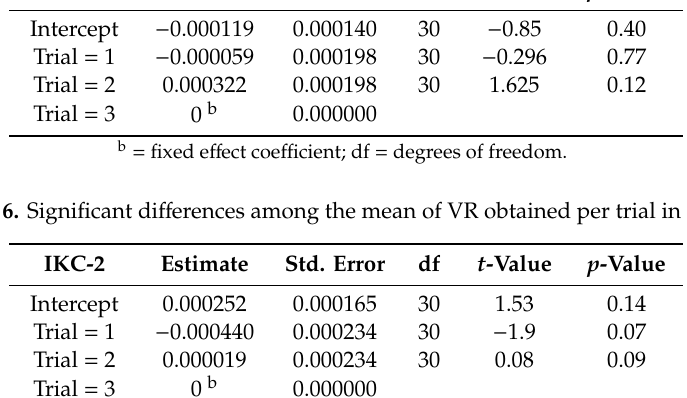
Table 5. Significant di ff erences among the mean of VR obtained per trial in CKC-1. CKC-1